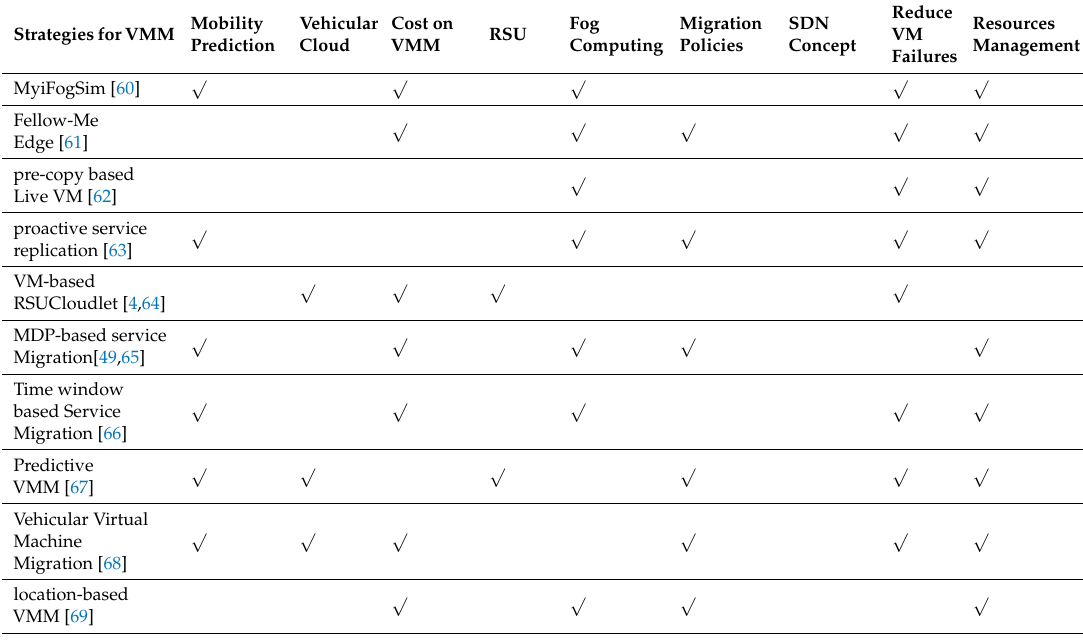
Table 3 recapitulates some strategies for VM service migration in vehicle cloud and fog computing- based architecture for cloud-based applications. Table 3. Virtual Machine migration techniques in Vehicle cloud